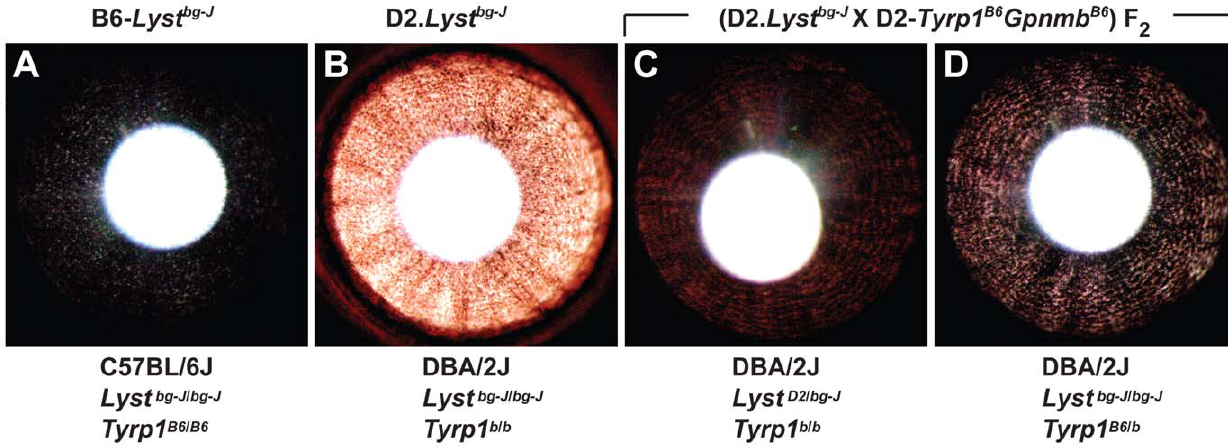
Figure 4. The DBA/2J-derived genetic enhancer of Lyst- mutant iris phenotypes maps to Tyrp1 . Irides of mice from 4 different genetic backgrounds with the Lyst bg-J mutation indicate that Tyrp1 mutation enhances Lyst -mutant iris phenotypes. (A) Subtle transillumination defect in B6- Lyst bg-J eyes. (B) Severe transillumination defect in D2. Lyst bg-J eyes. (C) Mild transillumination defect observed in (D2. Lyst bg-J X D2. Tyrp1 B6 Gpnmb B6 ) F 2 mice heterozygous for the Lyst bg-J mutation but homozygous for the Tyrp1 b mutation; note that the concentric pattern of defects resembles those of the Lyst bg-J phenotype. Similar results are observed in eyes of mice homozygous for wild-type Lyst alleles and the Tyrp1 b mutation. (D) Moderate transillumination defect observed in (D2. Lyst bg-J X D2. Tyrp1 B6 Gpnmb B6 ) F 2 mice heterozygous for the Tyrp1 b mutation, but homozygous for the Lyst bg-J mutation; note that presence of a wild-type Tyrp1 allele greatly alleviates the extent of transillumination in comparison to that in the D2. Lyst bg-J phenotype. Similar results are observed in eyes of mice homozygous for wild-type Tyrp1 alleles and the Lyst bg-J mutation. Genetic background, Lyst , and Tyrp1 genotype are summarized below each panel. The ‘‘B6’’ allele of Tyrp1 indicates the wild-type C57BL/6J allele and the ‘‘D2’’ allele of Lyst indicates the wild-type DBA/2J allele. All mice=1 month of